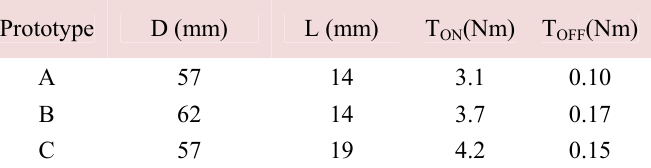
Table 2: Prototype dimensions and torque.